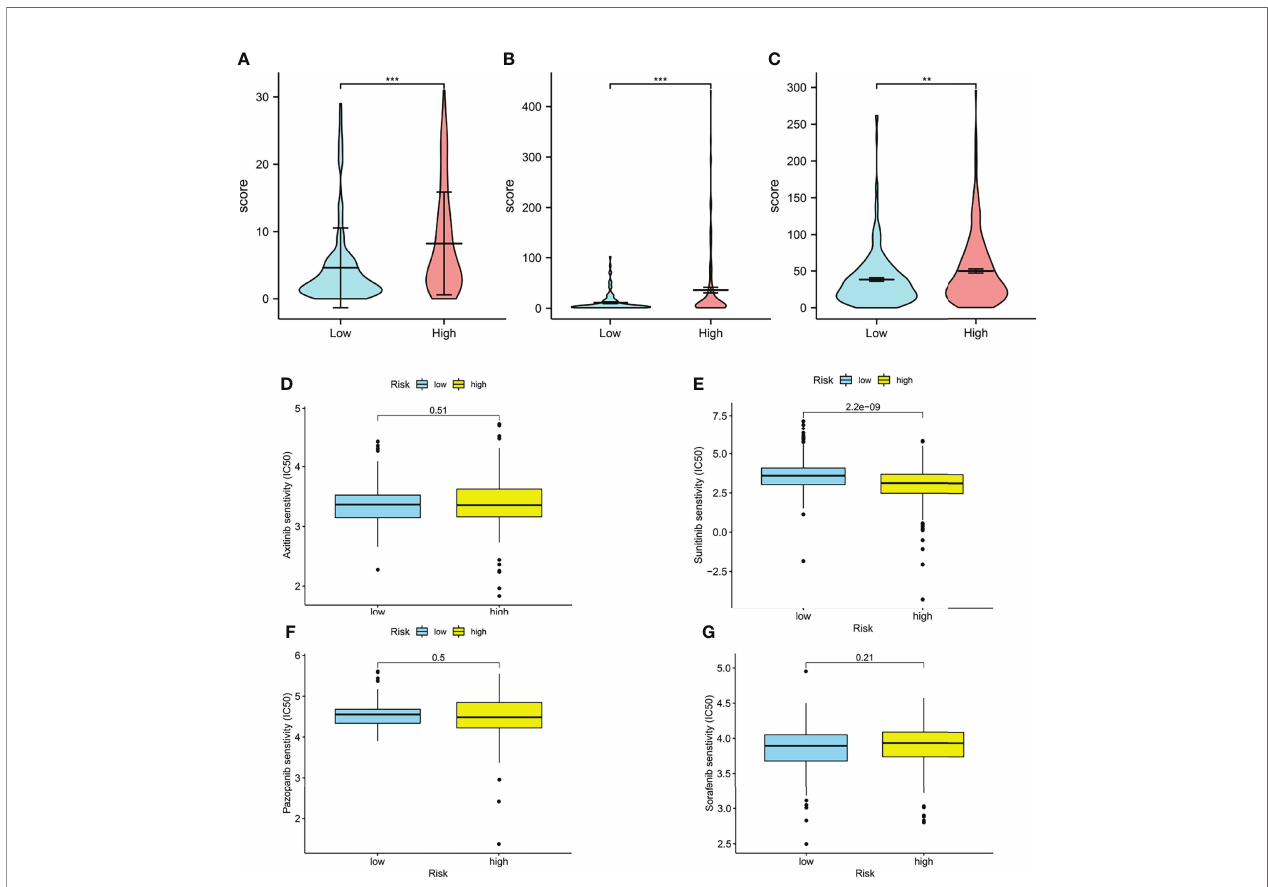
FIGURE 8 | Immune-related biomarkers and drug response. (A) Aneuploidy scores of high- and low-risk groups ( p < 0.001). (B) TCR ( p < 0.001) and BCR ( p < 0.01) scores of high- and low-risk groups. (D – G) Boxplots of estimated half-maximal inhibitory concentration (IC 50 ) of the high- and low-risk groups for antitumor drugs: axitinib ( D , p = 0.51), sunitinib ( E , p < 0.001), pazopanib ( F , p = 0.5), and sorafenib ( G , p = 0.21) (* p < 0.0, ** p < 0.001, *** p <